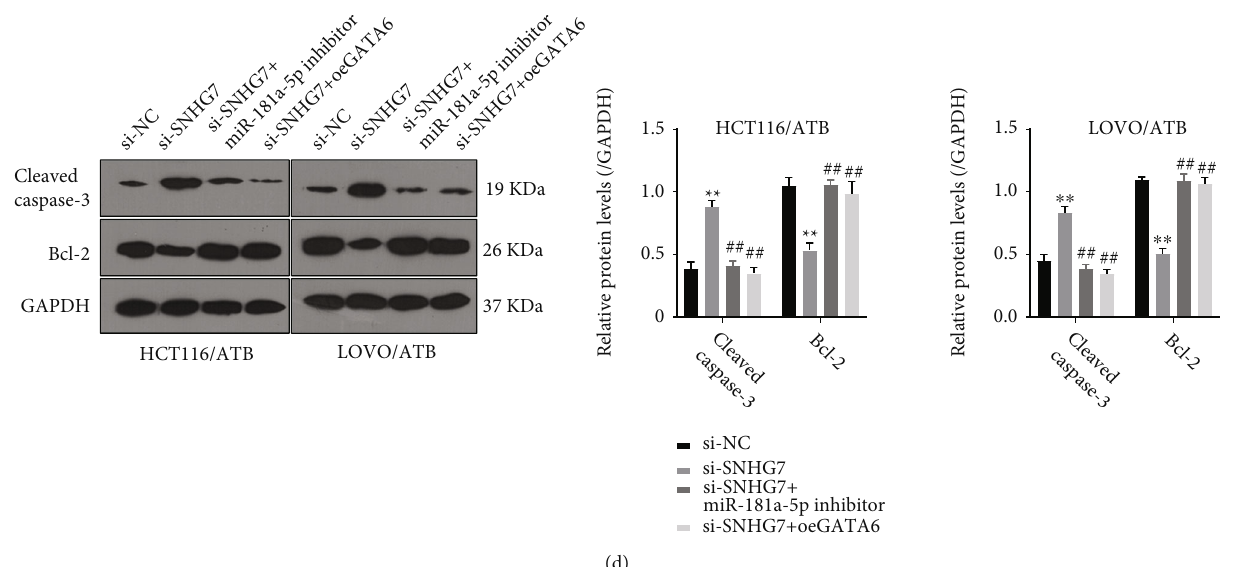
Figure 5: SNHG7 knockdown improves the ATB-sensitivity of CRC by regulating miR-181a-5p/GATA6. (a) Survival rate of HCT116/ATB and LOVO/ATB cell lines treated with 0, 2, 5, 10, and 20 μ M ATB. SNHG7 knockdown decreased the survival rate, which was partially recovered by overexpressing GATA6 or miR-181a-5p inhibitor. (b) Cell viability of siSNHG7 cell lines. The decreased cell viability was partially recovered by overexpressing GATA6 or miR-181a-5p inhibitor. (c) Flow cytometric analysis of the level of cell apoptosis. Down-regulation of SNHG7 in HCT116/ATB and LOVO/ATB cell lines increased cell apoptosis, which was partially reversed by overexpressing GATA6 or miR-181a-5p inhibitor. (d) Western blot to determine the levels of caspase-3 and Bcl-2, apoptosis-related proteins. Caspase-3 expression was increased, but Bcl-2 expression was decreased in siSNHG7 cell lines, which was partially reversed by overexpressing GATA6 or miR-181a-5p inhibitor. The statistical comparison was done by Student ’ s t -test (* P < 0 : 05 , ** P < 0 : 01 , and *** P < 0 : 001